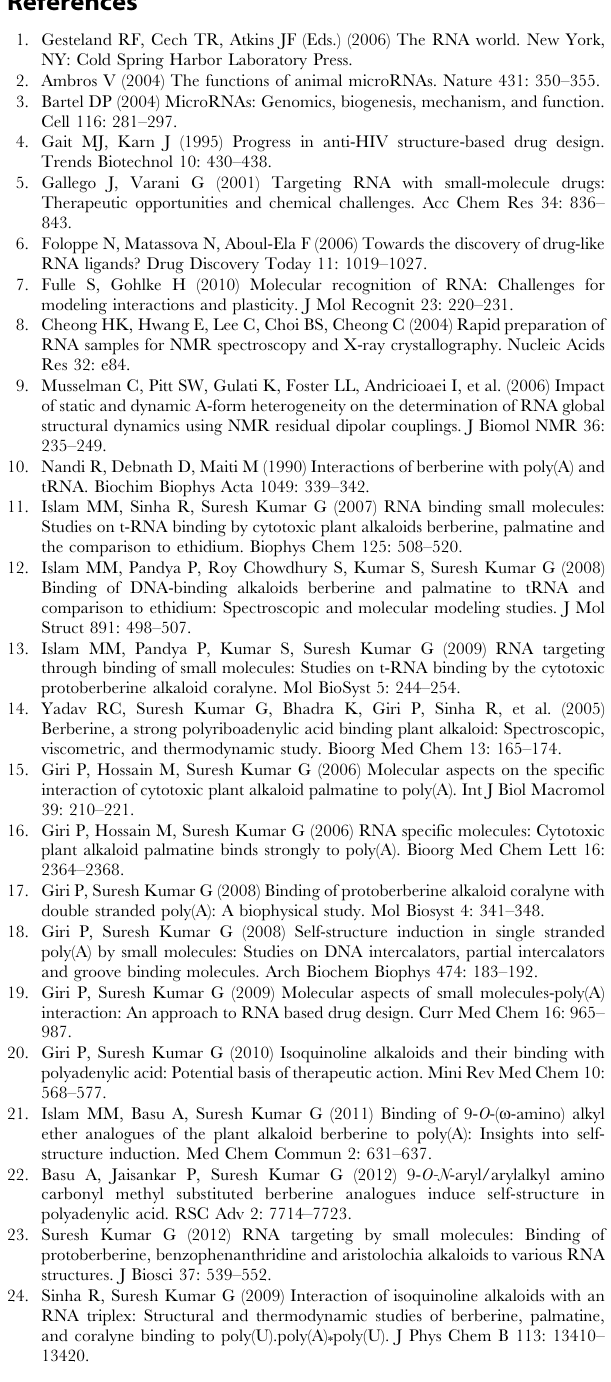
Figure S1 A plot of change in relative viscosity ( g / g 0 ) versus D/P (alkaloid/tRNA molar ratio) for BER (o), B2 ( & ), B3 ( N ) and B4 ( m ).